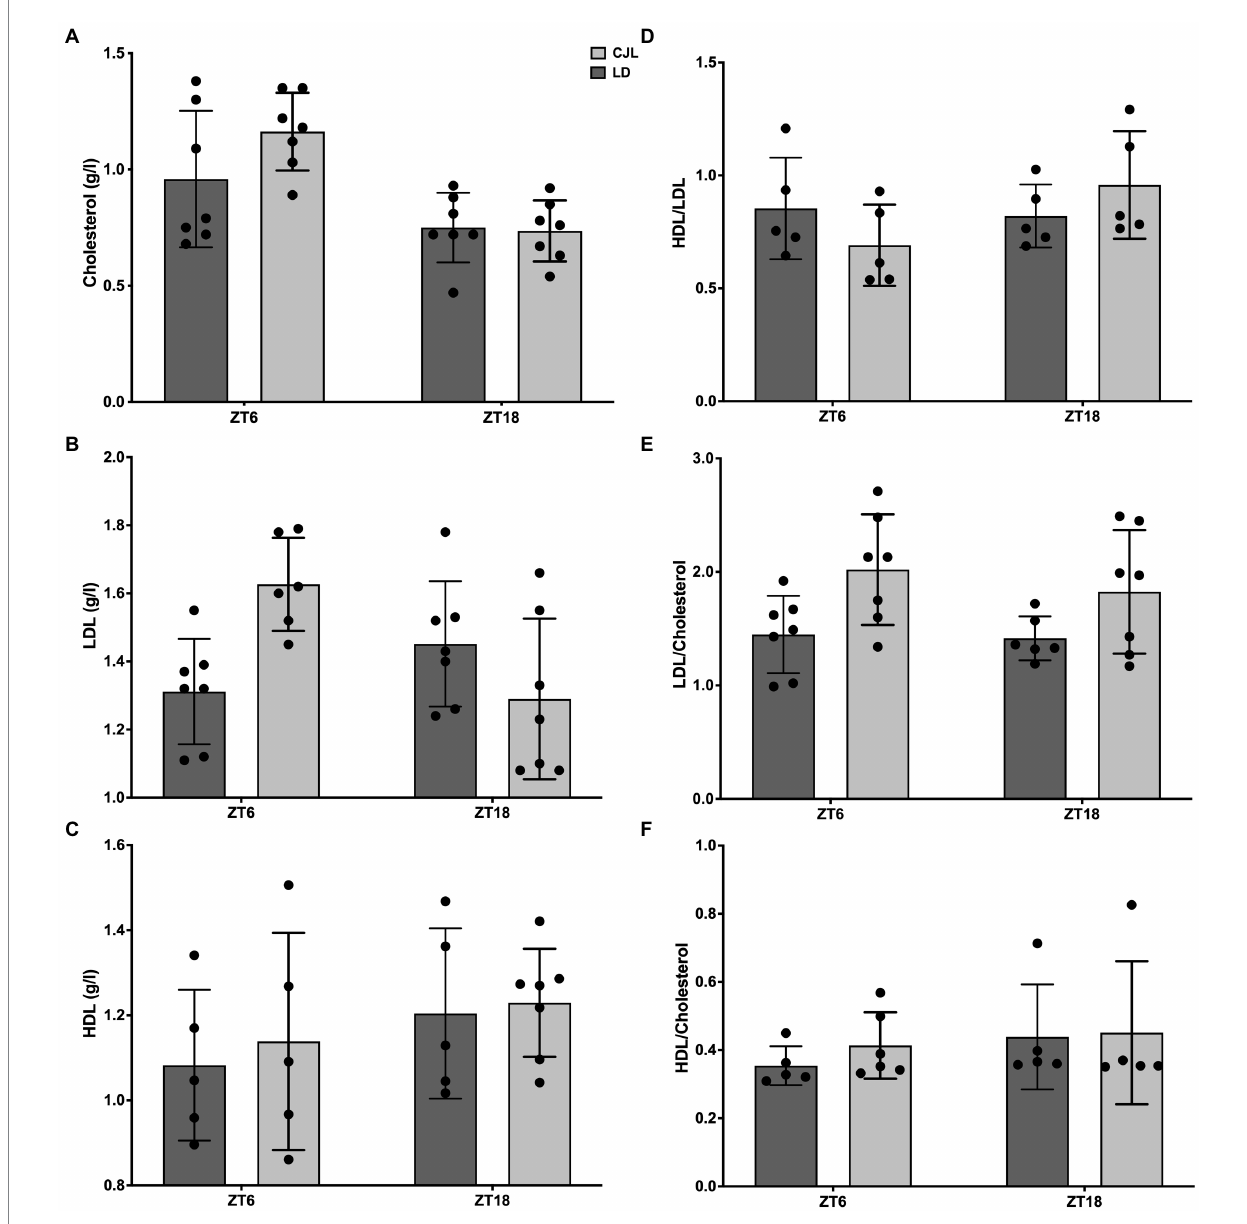
FIGURE 3 Daily changes in lipidemia (total cholesterolemia, LDL, HDL, HDL/LDL ratio, HDL/cholesterol ratio, and LDL/cholesterol ratio) in mice under LD and CJL at ZT6 and ZT18. (A) Total cholesterol (g/l) two-Way ANOVA, p = 0.1533, F = 2.174 for interaction; p = 0.0003, F = 18.39 for ZT; p = 0.2122, F = 1.643 for light schedule; followed by Sidak’s multiple comparisons test: ns; n = 7. (B) LDL (g/l) two-way ANOVA: p = 0.002, F = 11.33 for interaction; p = 0.178, F = 1.929 for ZT; p = 0.288, F = 1.180 for light schedule. (C) HDL (g/l), two-way ANOVA: ns. (D) HDL/LDL ratio, two-way ANOVA: ns. (E) LDL/Cholesterol ratio, two-way ANOVA, p = 0.6226, F = 0.248 for interaction; p = 0.4876, F = 0.4977 for ZT; p = 0.0061, F = 9.106 for light schedule; followed by Tukey’s multiple comparisons test: ns; n = 7. (F) HDL/Cholesterol ratio, two-way ANOVA: